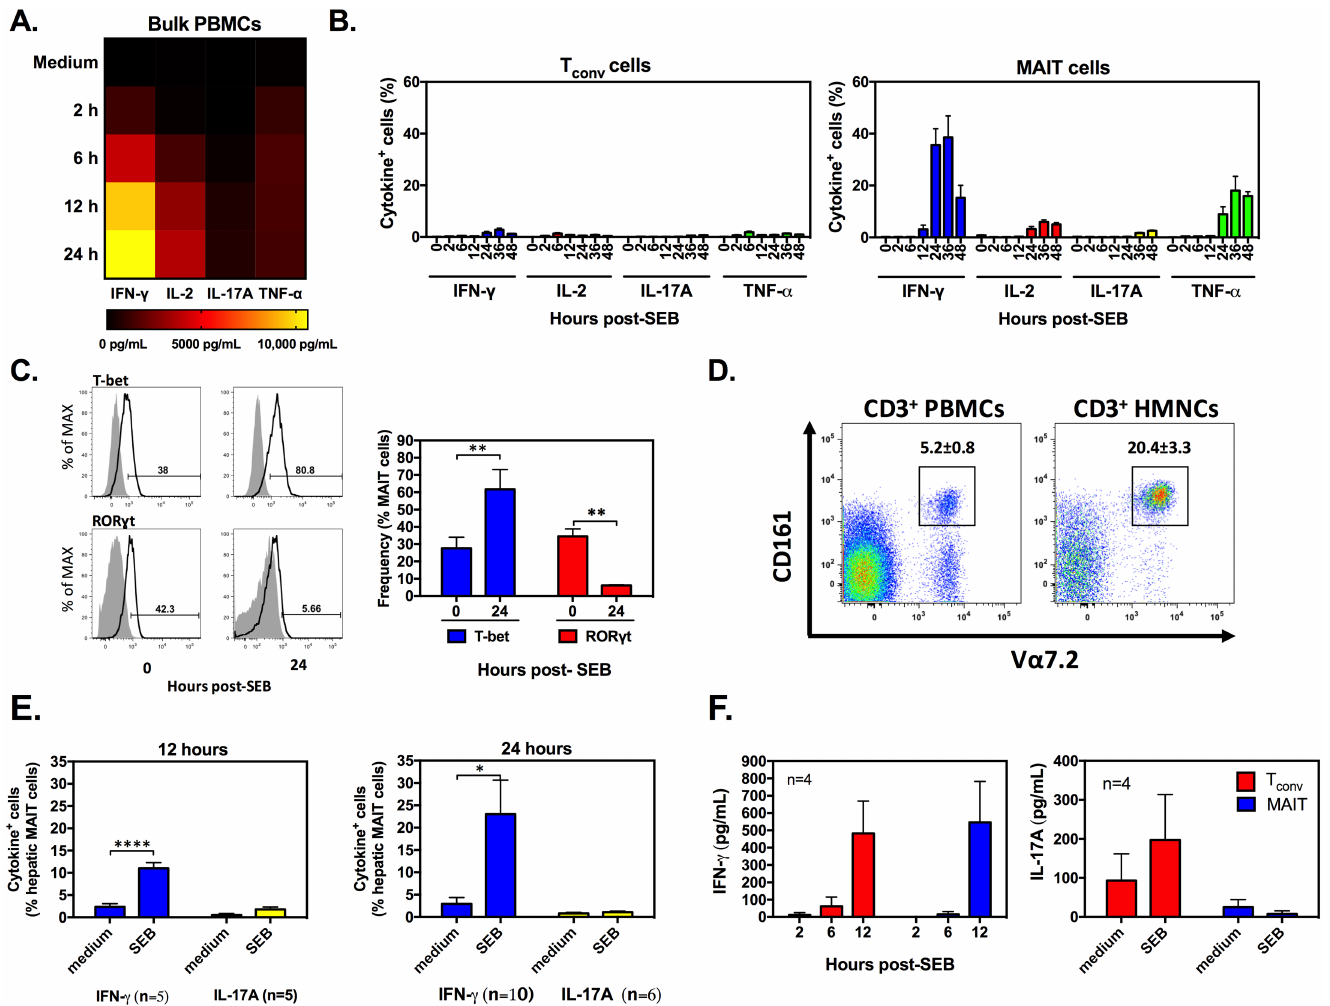
Fig 4. Staphylococcal enterotoxin B (SEB) stimulates human peripheral blood and hepatic mucosa-associatedinvariant T (MAIT) cells to produce classic pro-inflammatory cytokines except interleukin (IL)-17. Human peripheral blood mononuclear cells (PBMCs) were stimulatedwith 100 ng/mL of SEB, and culture supernatantswere collectedat indicatedtime points for cytokine analysis( A ). Data from 4 healthy donorswere averaged and used to generatea heat map illustratinginterferon (IFN)- γ , interleukin (IL)-2, IL-17A, and tumor necrosis factor (TNF)- α levels. PBMCs ( n = 8) were exposedto SEB, and the frequenciesof IFN- γ + , IL-2 + , TNF- α + , and IL-17 + events amongconventional T (T conv ) and MAIT cells were determined at indicatedtime points ( B ). Freshly isolatedand SEB-stimulated PBMCs ( n = 3) were also examinedto assess the intracellularT-bet and ROR γ T contents of MAIT cells relative to background stainingwith isotype controls (filled histograms in representative plots) ( C ). Non-parenchymal hepaticmononuclear cells (HMNCs) were isolated from tumor-free liver tissue samples of patients with colorectal carcinoma ( n = 20), in which CD3 + V α 7.2 + CD161 + MAIT cell frequencies were calculatedand comparedwith those determinedin 20 PBMC samples( D ). HMNCs were incubatedfor 12 h or 24 h with SEB, followedby cytofluorimetric analysisof IFN- γ and IL-17 production by hepaticMAIT cells ( E ). In a limited number of experiments, blood MAIT and T conv cells were purifiedusing a cell sorter and co-incubated with autologousCD14 + monocytesin the presenceor absenceof SEB. IFN- γ and IL-17A contents of culture supernatants were measuredafter 2 h, 6 h, or 12 h by ELISA ( F ). * , ** , and **** denote p < 0.05, p < 0.01, and p < 0.0001, respectively.The underlying data for this figure can be found in S1 Data, and our gating strategies are providedin S2 Data.